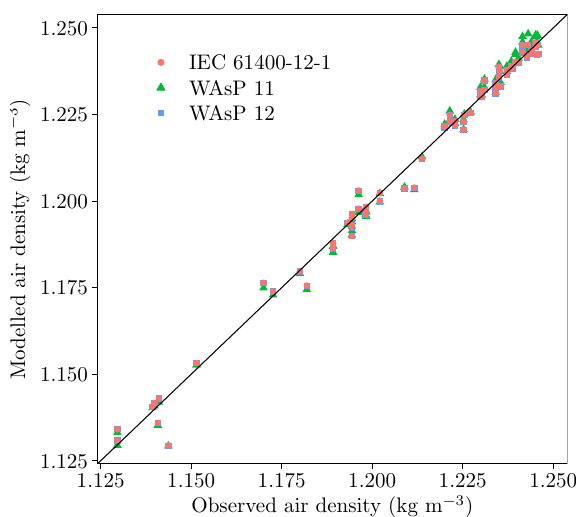
Figure 2. Scatter plot of three different methods (see text). Note that the points from the Zugspitze station were omitted because it had a very low ρ , which reduced the readability of the plot. Table 1. Summary error metrics from the methods presented in this paper. The modelled and observed air density at site i of the total number of sites N = 77 are denoted as x i and y i , respectively. Then, the